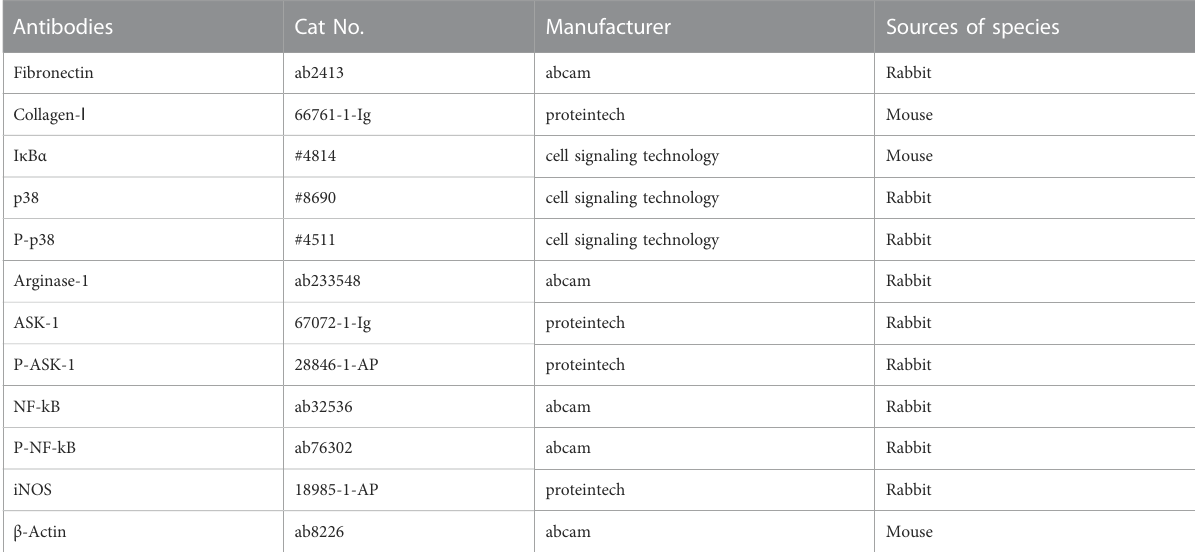
TABLE 2 (Antibody list) Primary antibodies for Western Blot. Antibodies Cat